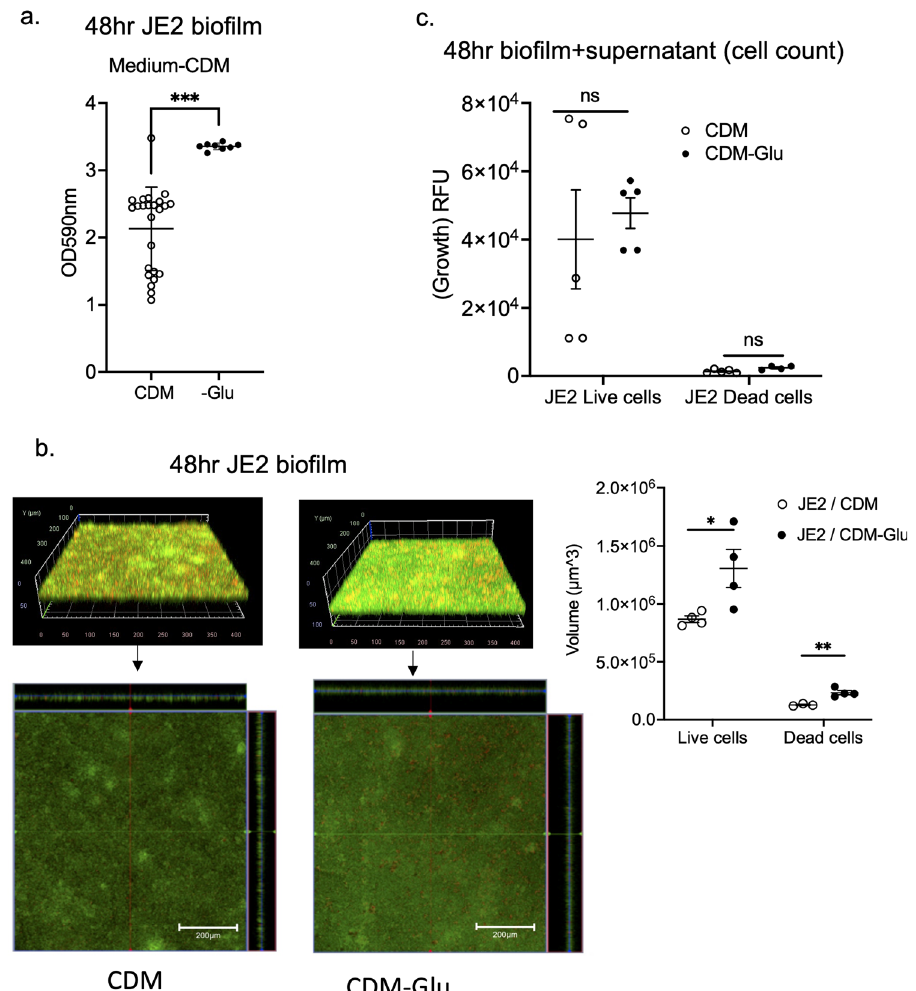
Fig. 3 The role of exogenous glutamate in bio fi lm formation. a Absorbance values of crystal violet assays of 48 h JE2 bio fi lms using complete CDM containing glucose medium (CDM) and glutamate (Glu)-depleted from CDM medium (CDM-Glu). Data are shown as mean ± SD of 8 replicates. Student t test was performed. *** p < 0.001. b Images of JE2 bio fi lm after LIVE/DEAD staining by CLSM and channel-speci fi c volume calculated by Image J. The volume of bio fi lm calculated by using the voxel counter plugin in Image J and shown as mean ± SD of four independent locations. One-way ANOVA with post hoc Bonferroni ’ s multiple comparisons test vs USA300 JE2. * and ** p < 0.05 and p < 0.01. c Cell counts were determined by using fl uorescence intensity of the whole 48-h bio fi lm and supernatant as a surrogate. Fluorescence intensity was measured as relative fl uorescence unit (RFU) because the spectra of collected light should be corrected for instrument effects. Data are shown as mean ± SD of 8 replicates. One-way ANOVA with post